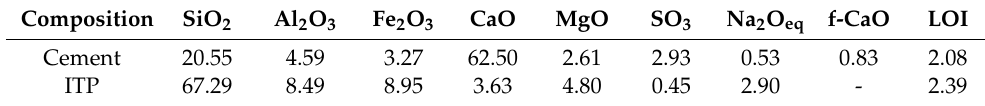
Table 1. Chemical compositions of raw materials (Mass/%).